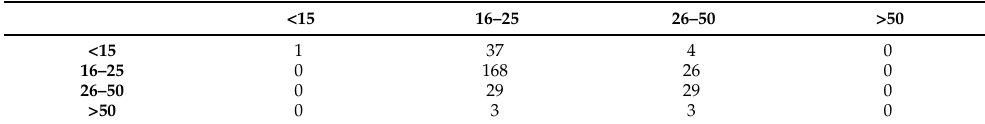
Table 6. The confusion matrix for age classification on the KHATT dataset.